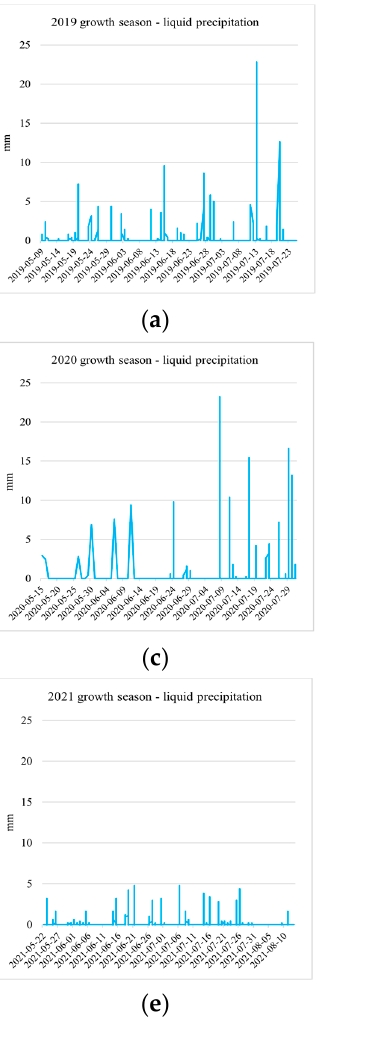
Figure 7. Meteorological critical data for all growing seasons, specifically precipitation, solar radiation, and temperature. The graphics concern the period until the achievement of growth curve stabilization, which means that the period covered is variable according to the growing season. 2019 growing season: 2019/05/09–2019/07/25 ( a ) liquid precipitation (mm) and ( b ) solar radiation (W/m 2 ) and temperature ( ◦ C); 2020 growing season: 2020/05/15–2020/07/31 ( c ) liquid precipitation (mm), and ( d ) solar radiation (W/m 2 ) and temperature ( ◦ C); and 2021 growing season: 2021/05/18–2021/08/21, ( e ) liquid precipitation (mm) and ( f ) solar radiation (W/m 2 ) and temperature ( ◦